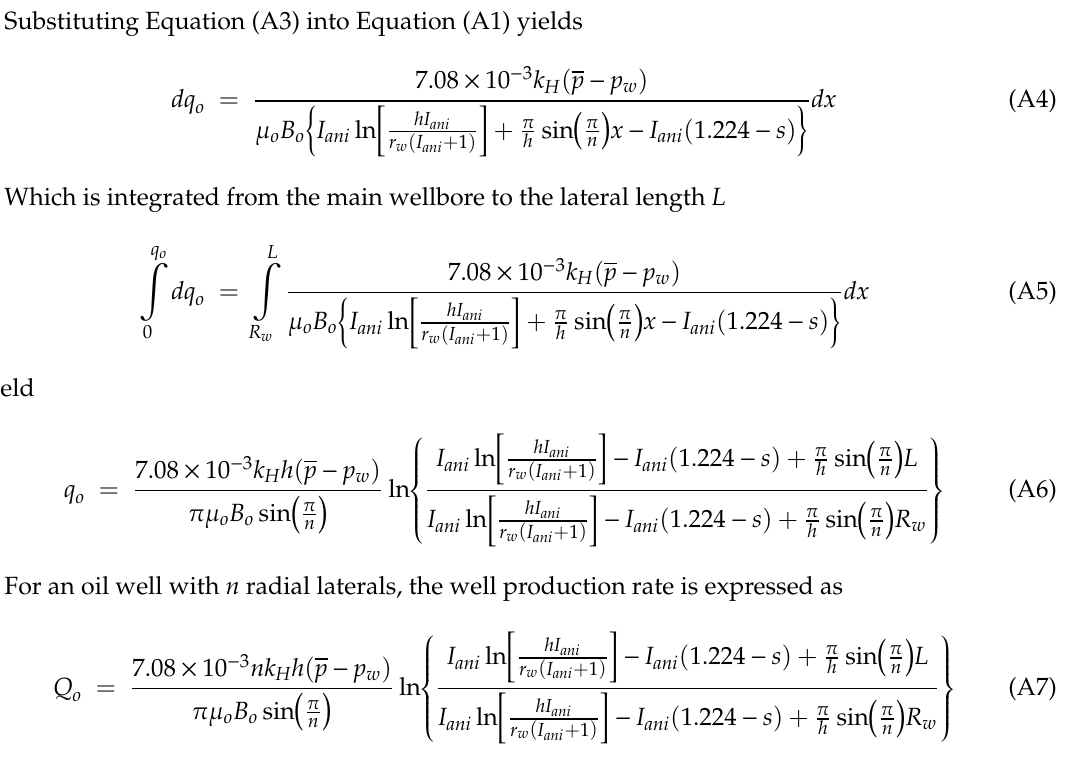
Figure A1. Sketch of a well with n radial laterals of equal-geometry.